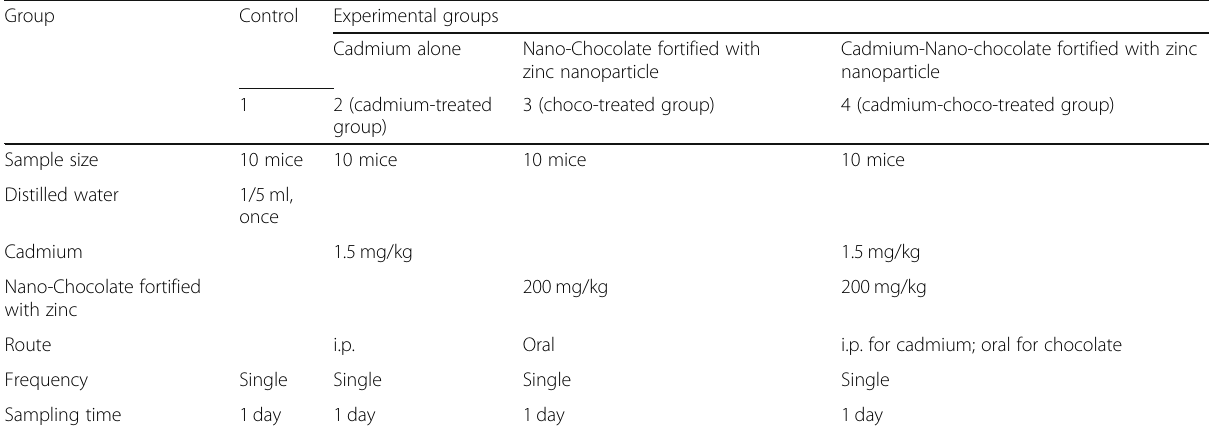
Table 1 The experimental design of the experimental Group